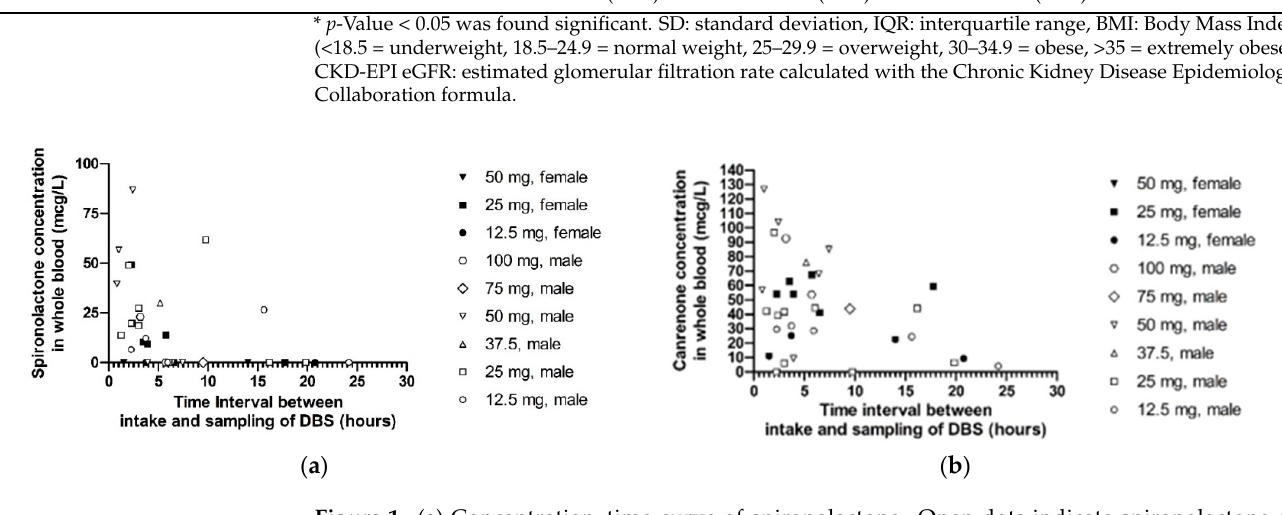
Figure 1. ( a ) Concentration–time curve of spironolactone. Open dots indicate spironolactone of males and closed dots (black) of females. Each dose (taken once daily) is represented by a different icon. ( b ) Concentration–time curve of canrenone, the active metabolite of spironolactone. Open dots indicate canrenone of males and closed dots (black) of females. Each dose (taken once daily) is represented by a different icon.